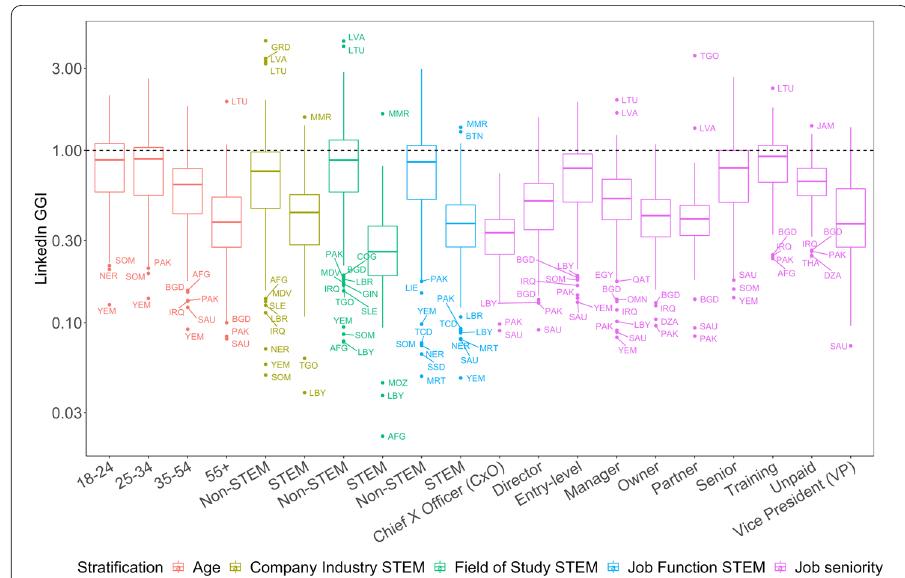
Figure 2 Box and Whisker plot for LinkedIn Gender Gap Index (GGI) by different characteristics. Note: Y -axis values are on a log (base 10)